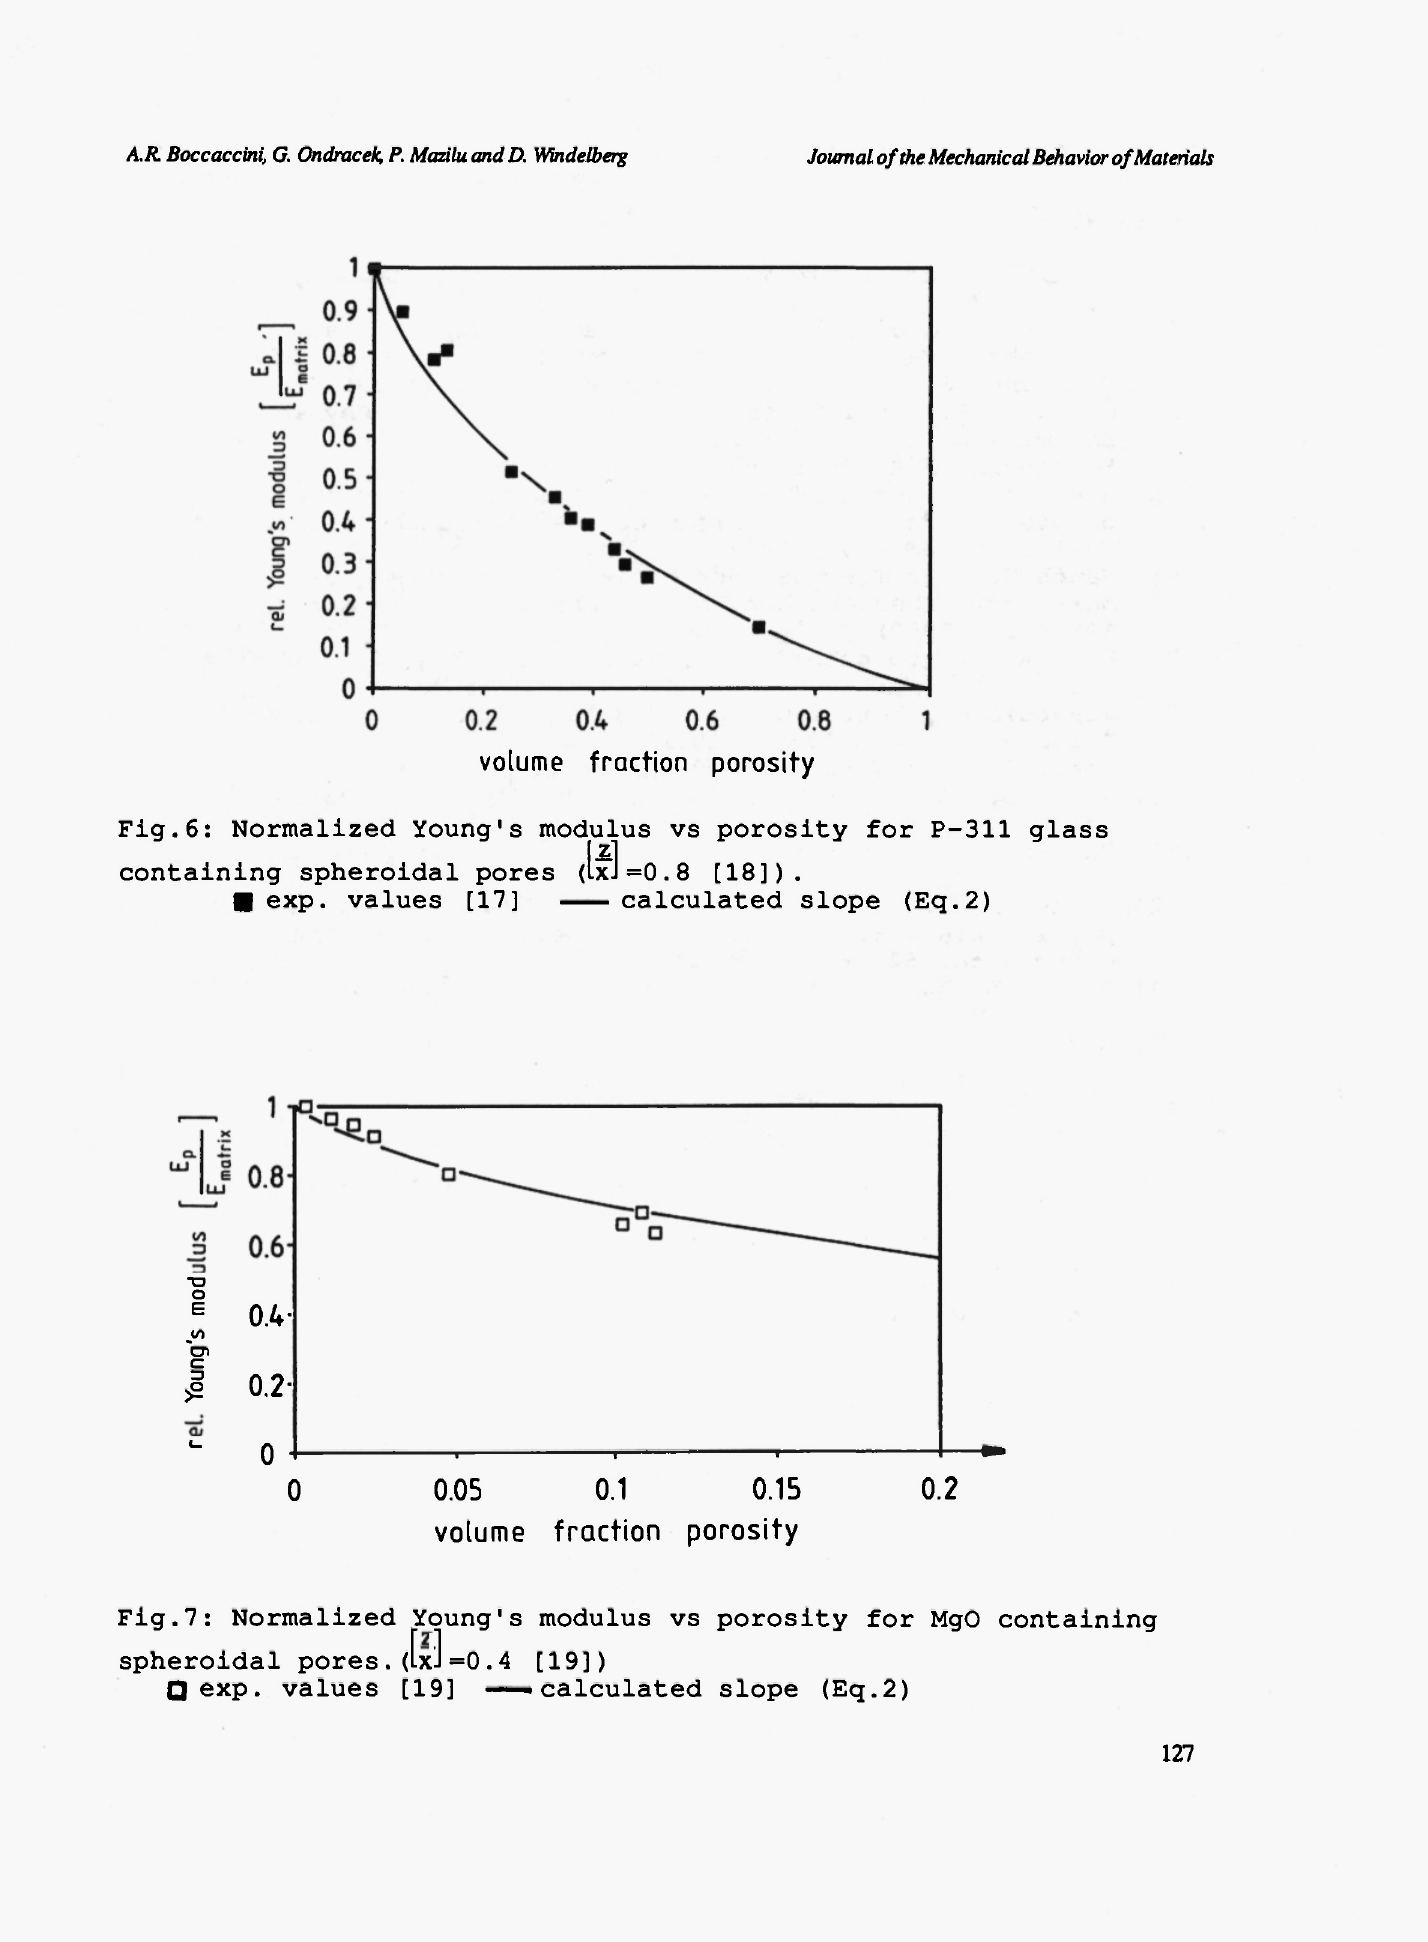
Fig.7: Normalized Young's modulus vs porosity for MgO containing spheroidal pores . ([χ] =0 . 4 [19]) Q exp. values [19] ——calculated slope